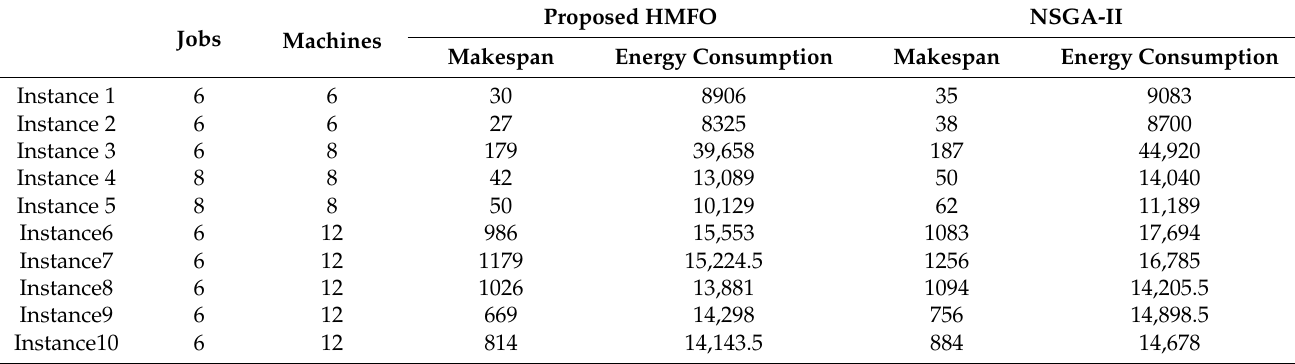
Table 9. Results of the practical instances with makespan and energy consumption